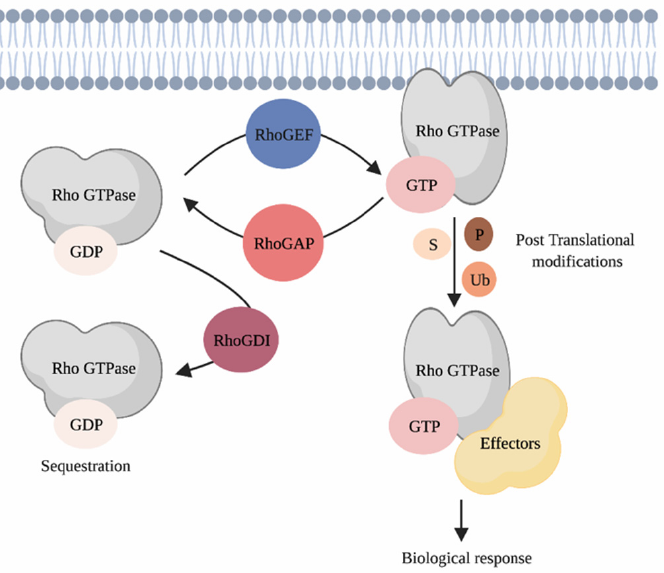
Figure 2. Regulating Rho GTPases. Classical Rho GTPases cycle between an inactive GDP-bound and an active GTP-bound state. This cycle is regulated by three families of proteins, i.e., the RhoGEFs, the RhoGAPs and the RhoGDIs. When bound to GTP, Rho GTPases interact with their effectors, which triggers signal transduction in cells. Post-translational modifications such as phosphorylation, ubiquitination and SUMOylation ensure the coordination of Rho GTPases activity in space and time. P = phosphorylation, S = SUMOylation, Ub = ubiquitination. Created with BioRender.com, accessed on 20 August 2021.